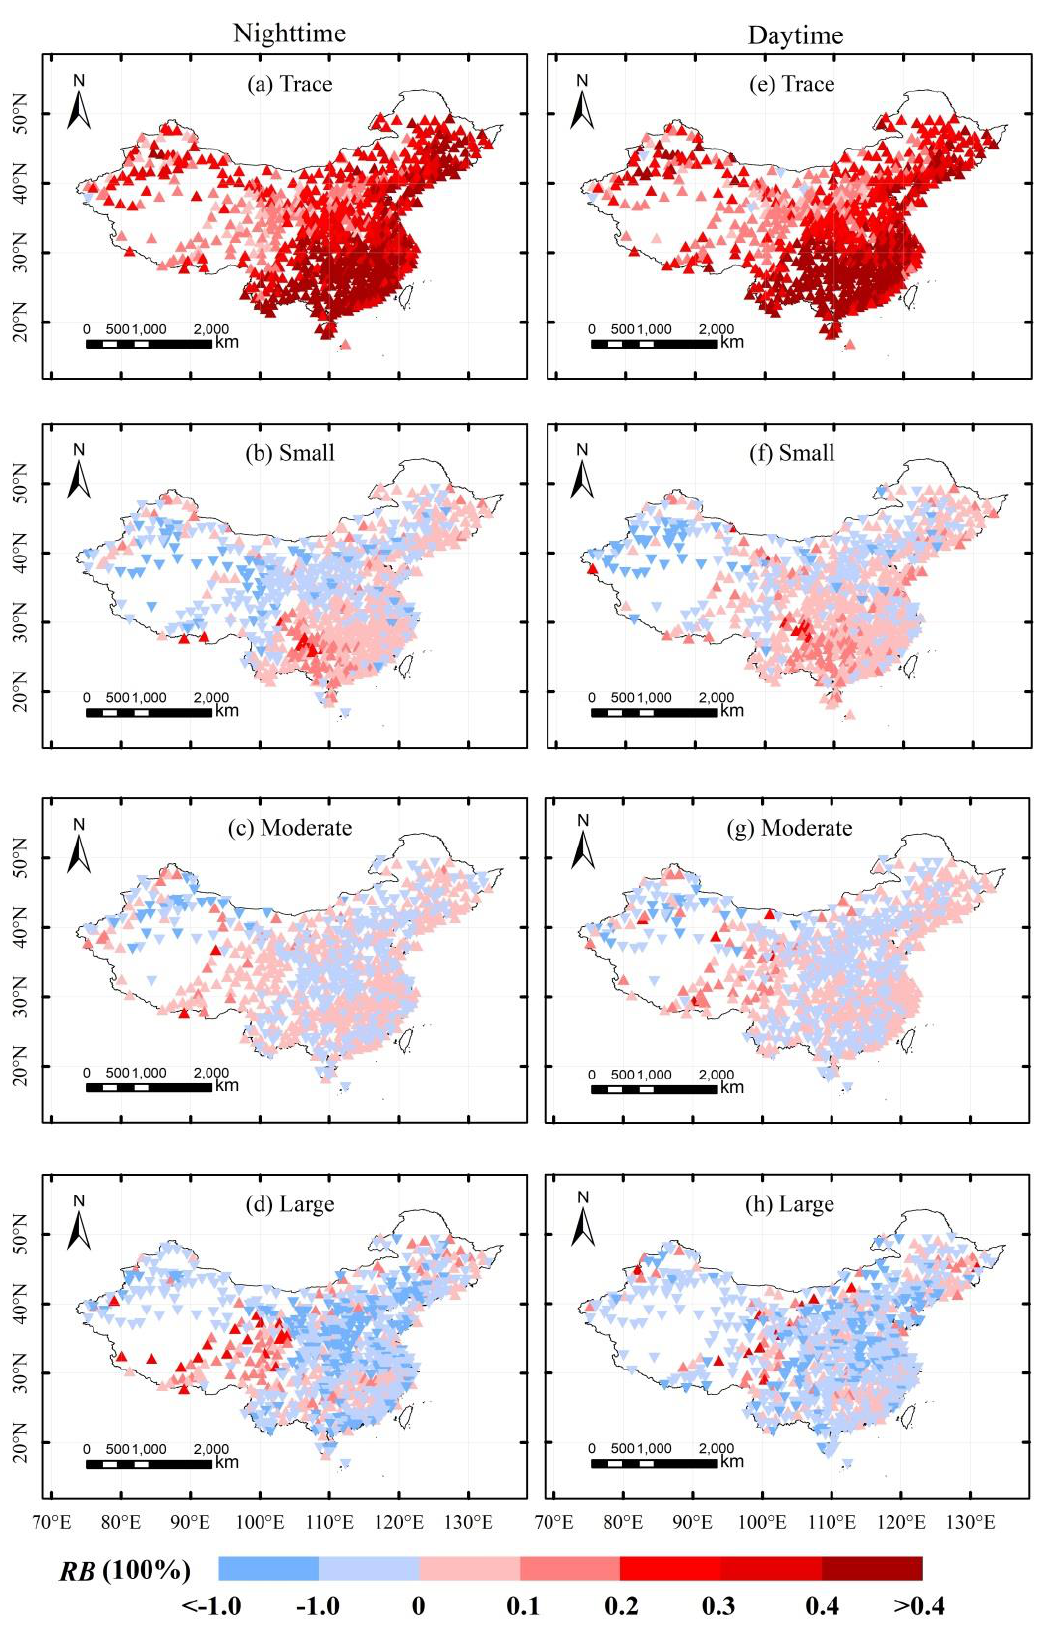
Figure 9. As in Figure 8, but for the intensity of precipitation.